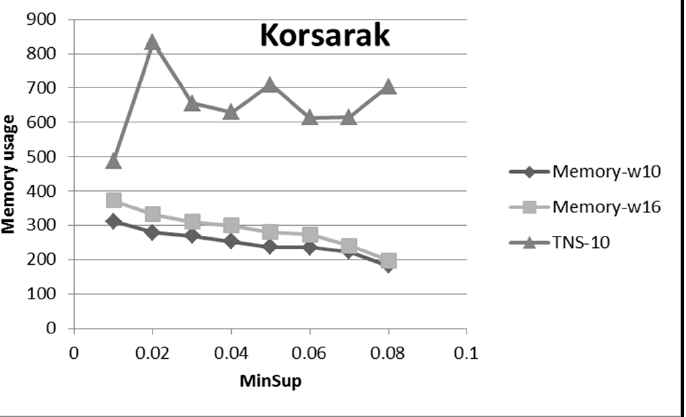
Figure 24. Comparison of memory usage for the TNS with the NRD-DBV algorithm for (Korsarak) dataset.